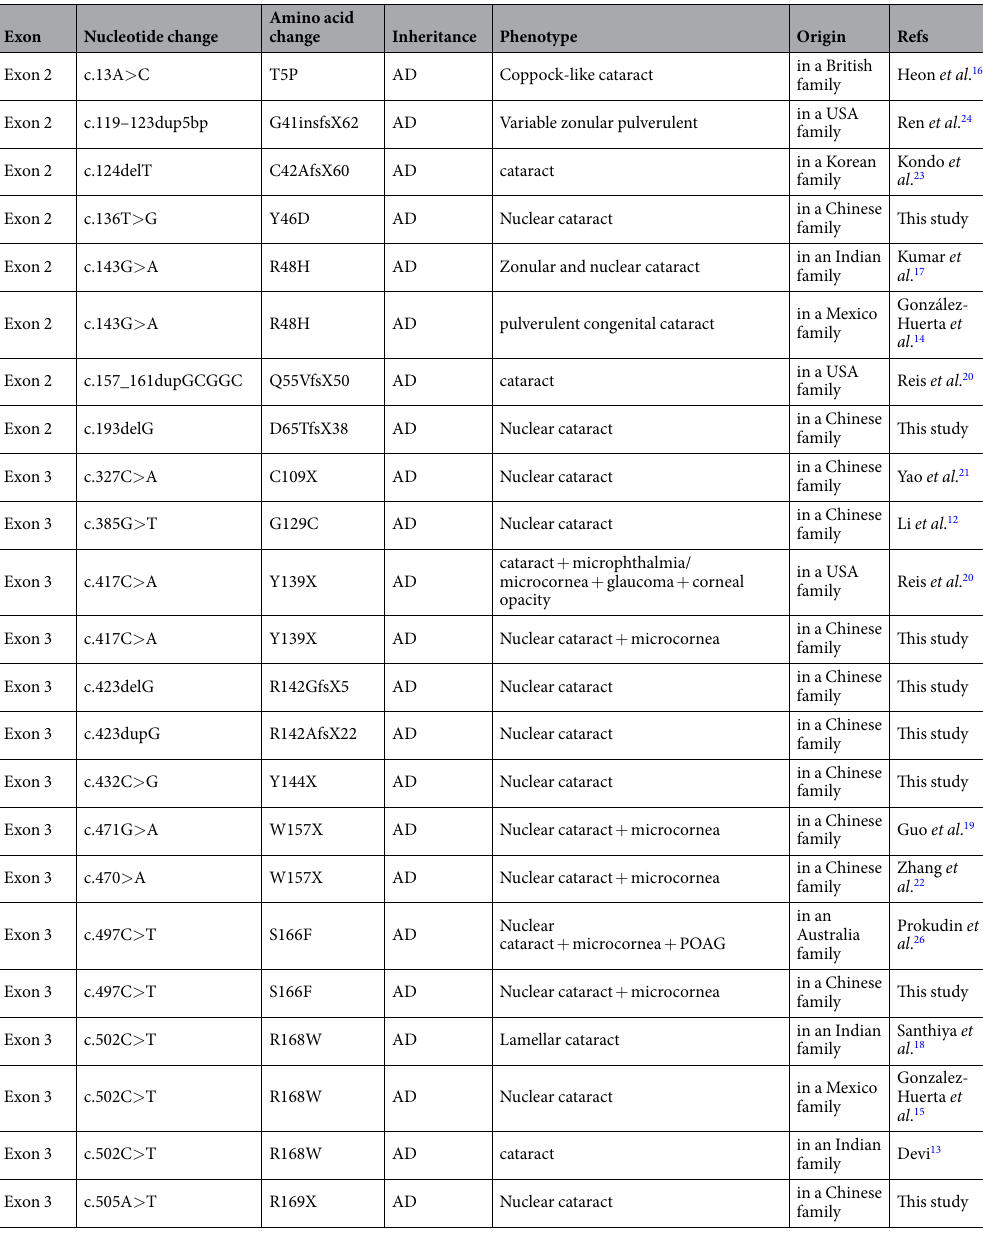
Table 1. Summary of mutations in CRYGC associated with